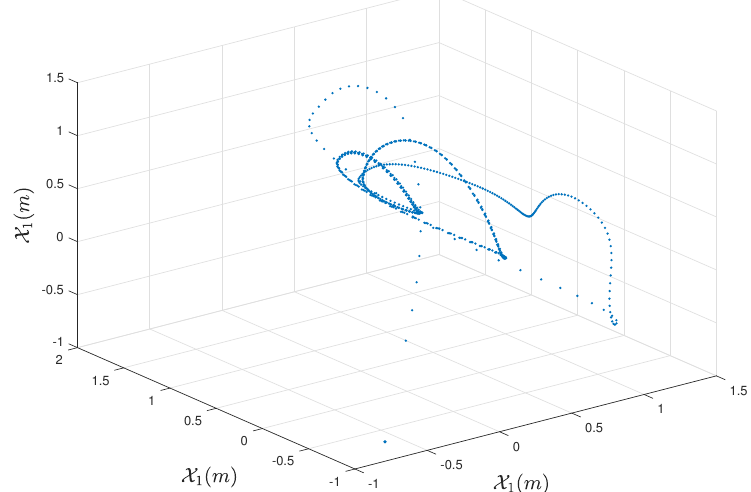
Figure 4. Phase portrait of system